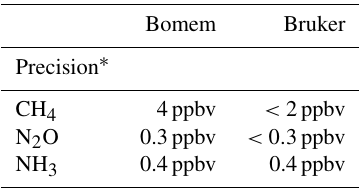
Table 7. The precisions of CH 4 , N 2 O, and NH 3 for OP-FTIR Bomem MB100 and Bruker IR cube